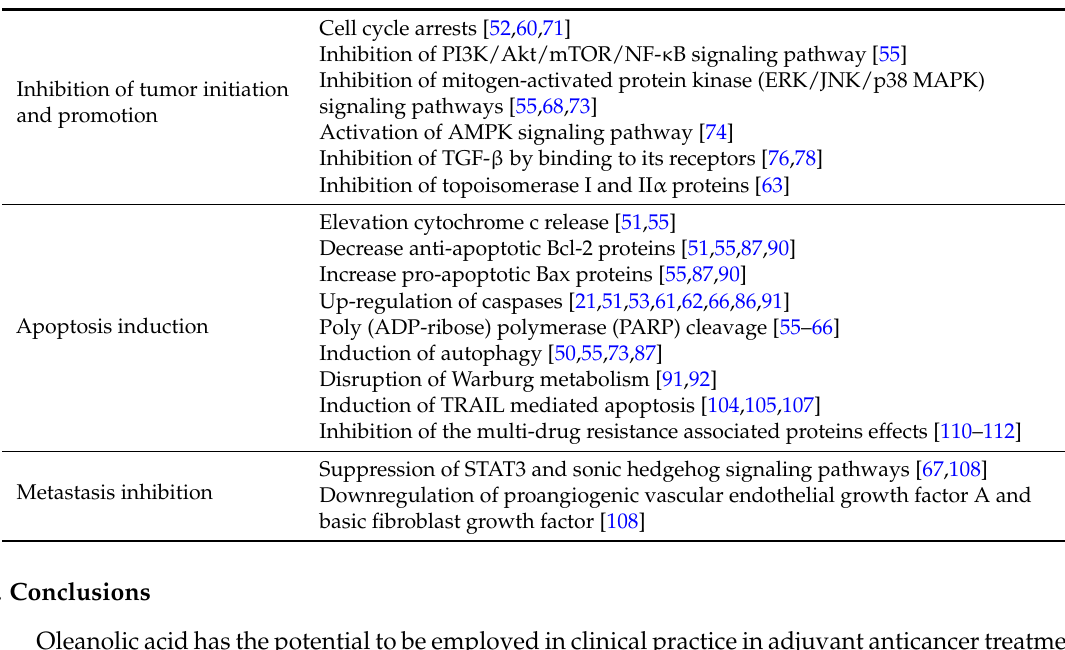
Table 2. Main anti-cancer effects of oleanolic